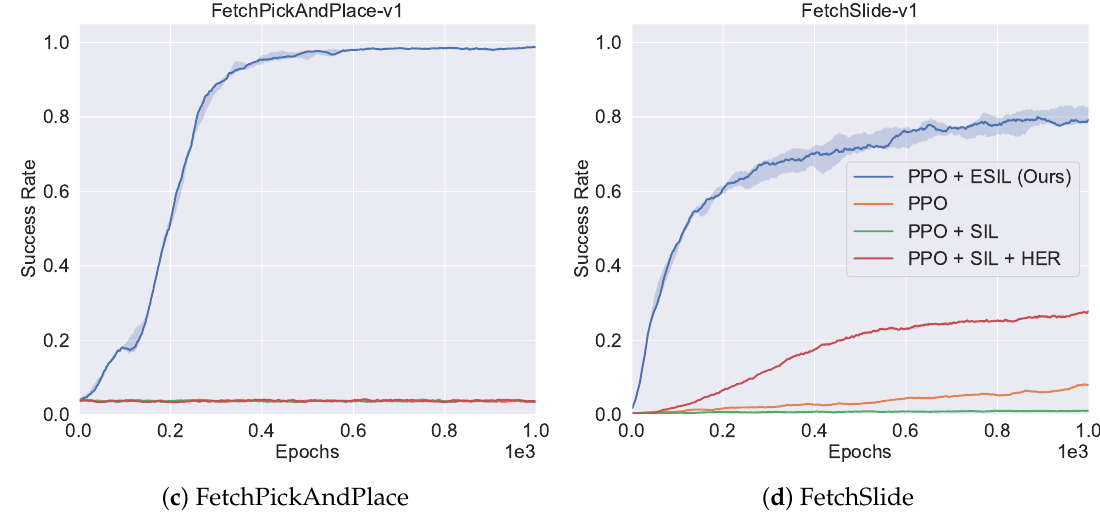
Figure 5. Results of comparison between ESIL and on-policy baselines on all Fetch